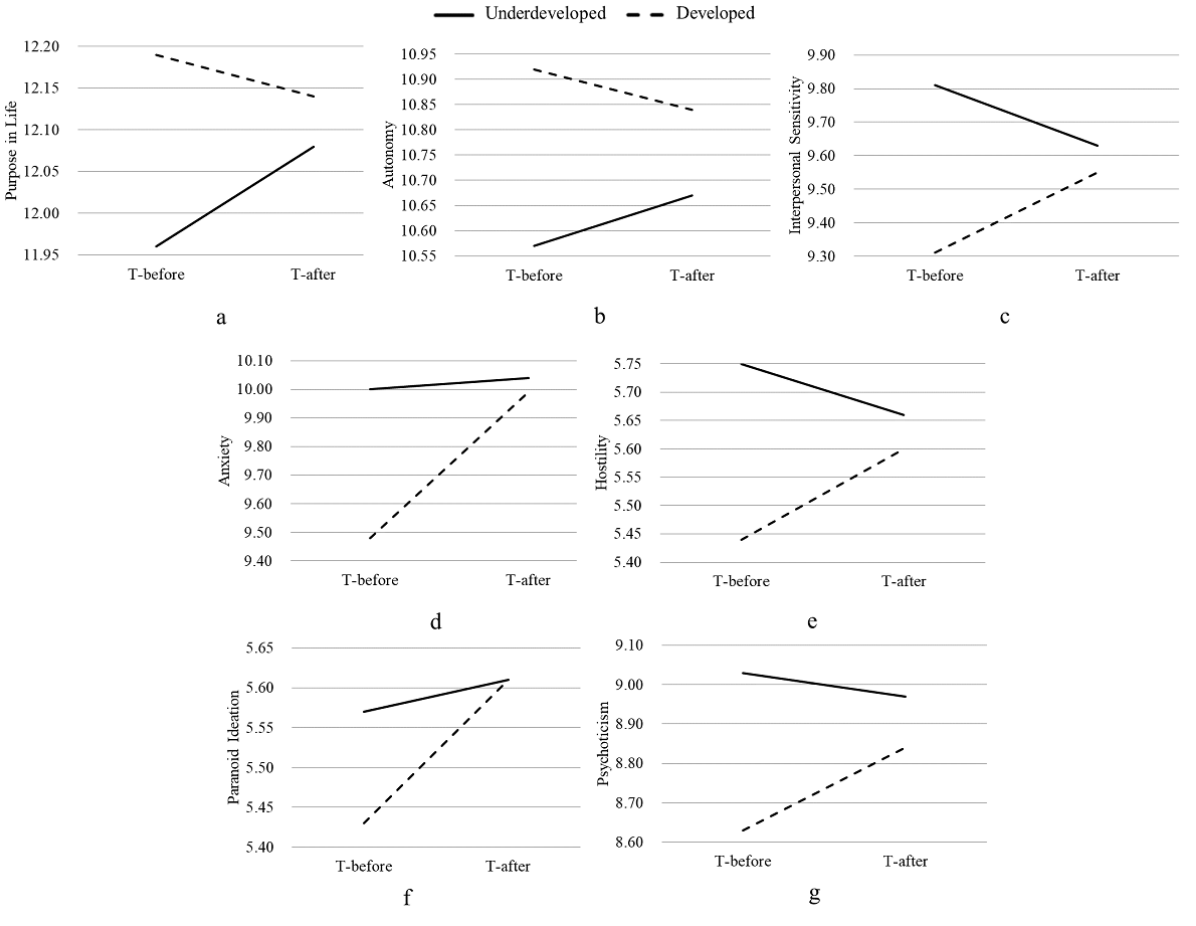
Figure 2. Interactions of area and time on (a) purpose in life, (b) autonomy, (c) interpersonal sensitivity, (d) anxiety, (e) hostility, (f) paranoid ideation, and (g) psychoticism in the residential lockdown areas. T-after: the period after the residential lockdown; T-before: the period before the residential